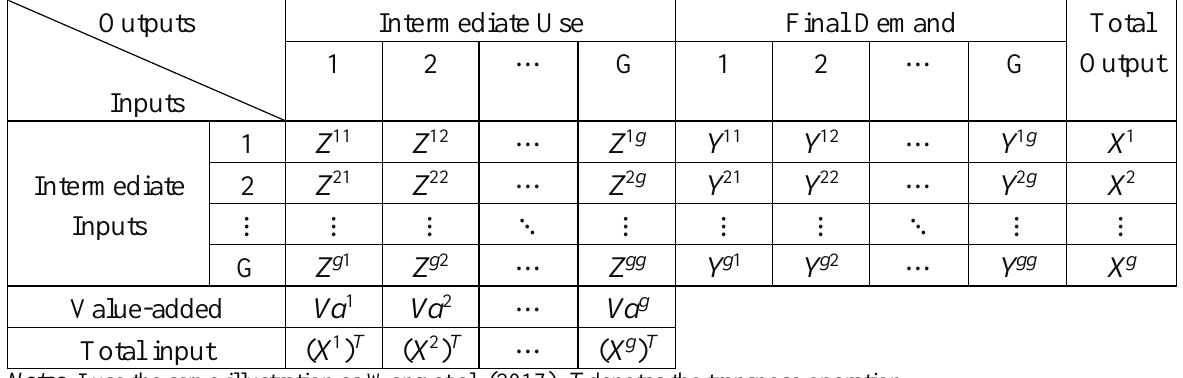
Table 1 An illustration of a World Input-Output